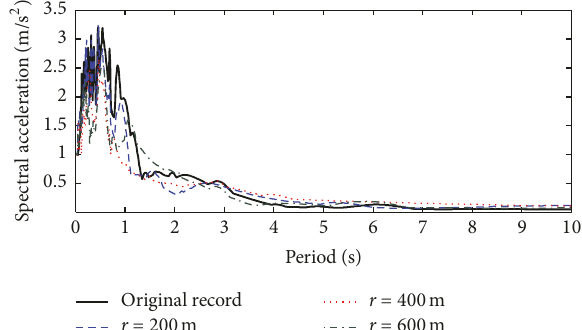
Figure 6: Comparison of response spectra with 2% damping ratio of simulated motions to that of the original record.